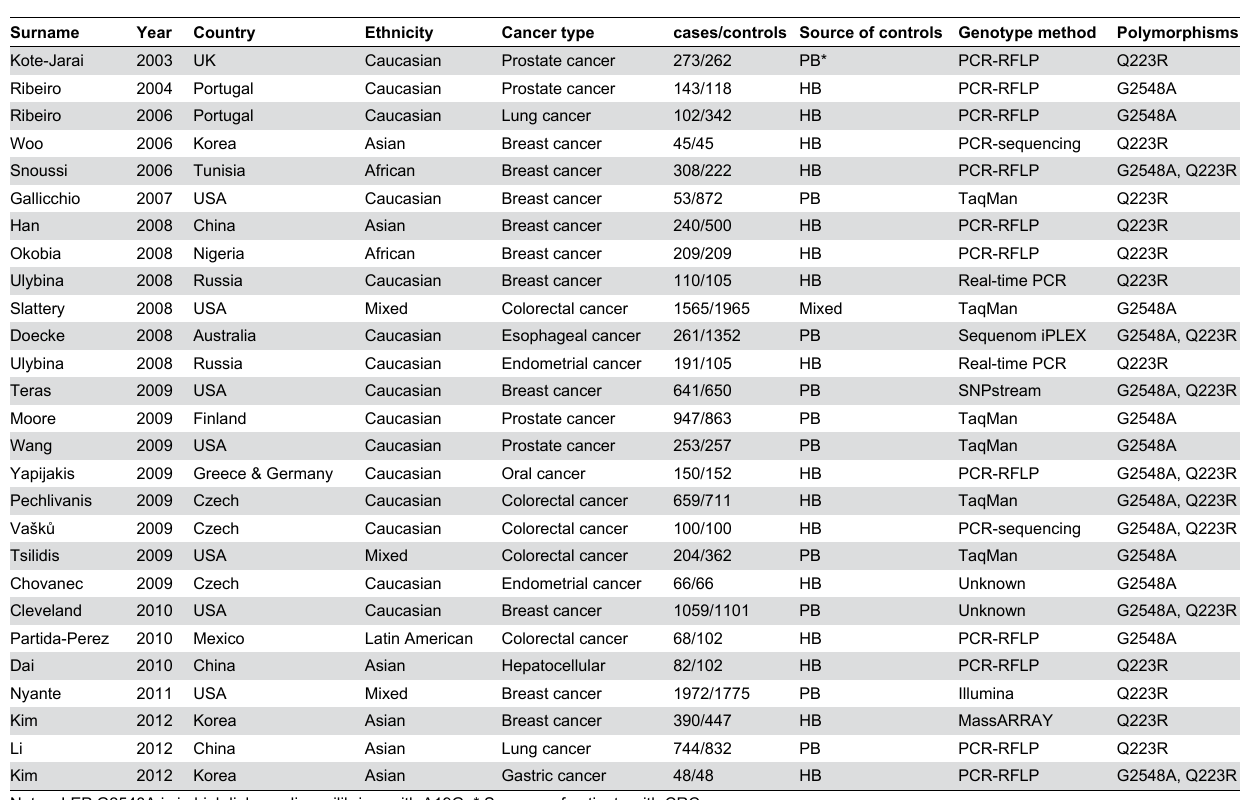
Table 1. Characteristics of studies included in the